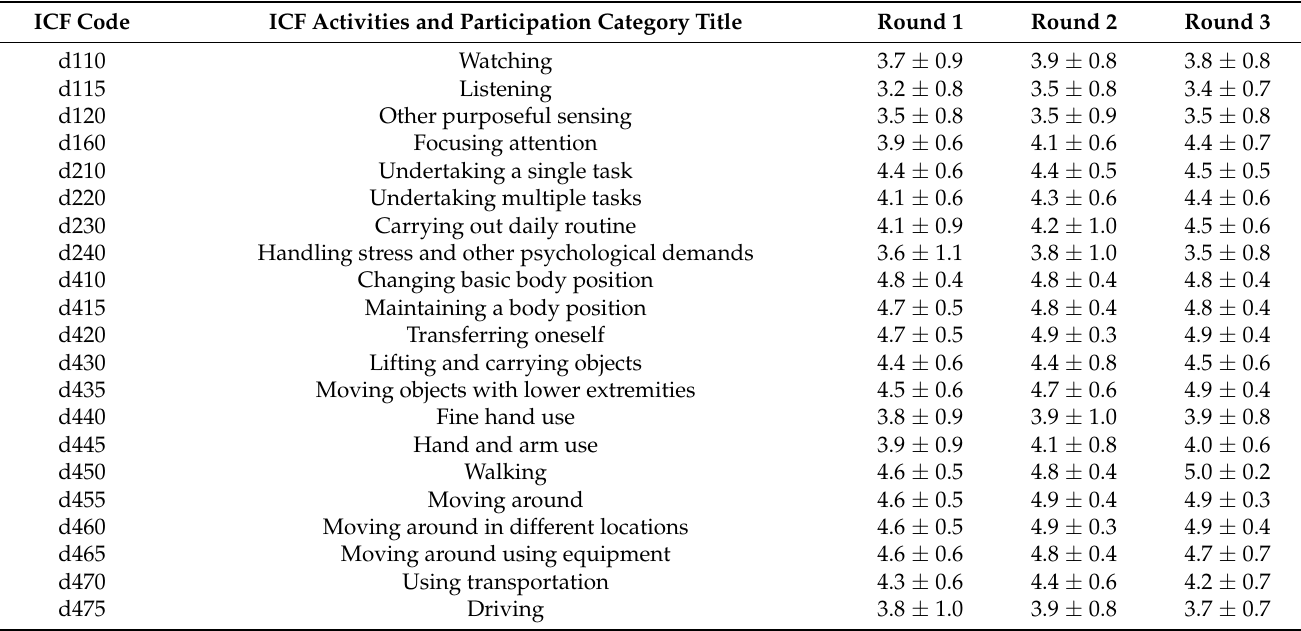
Table 3. Delphi Consensus rating scores of ICF activities and participation categories for hip fracture